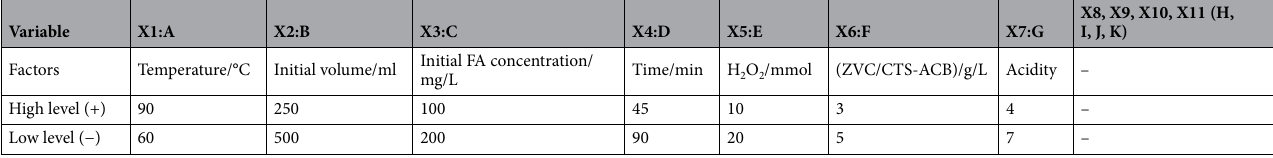
Table 2. Factors of PB design